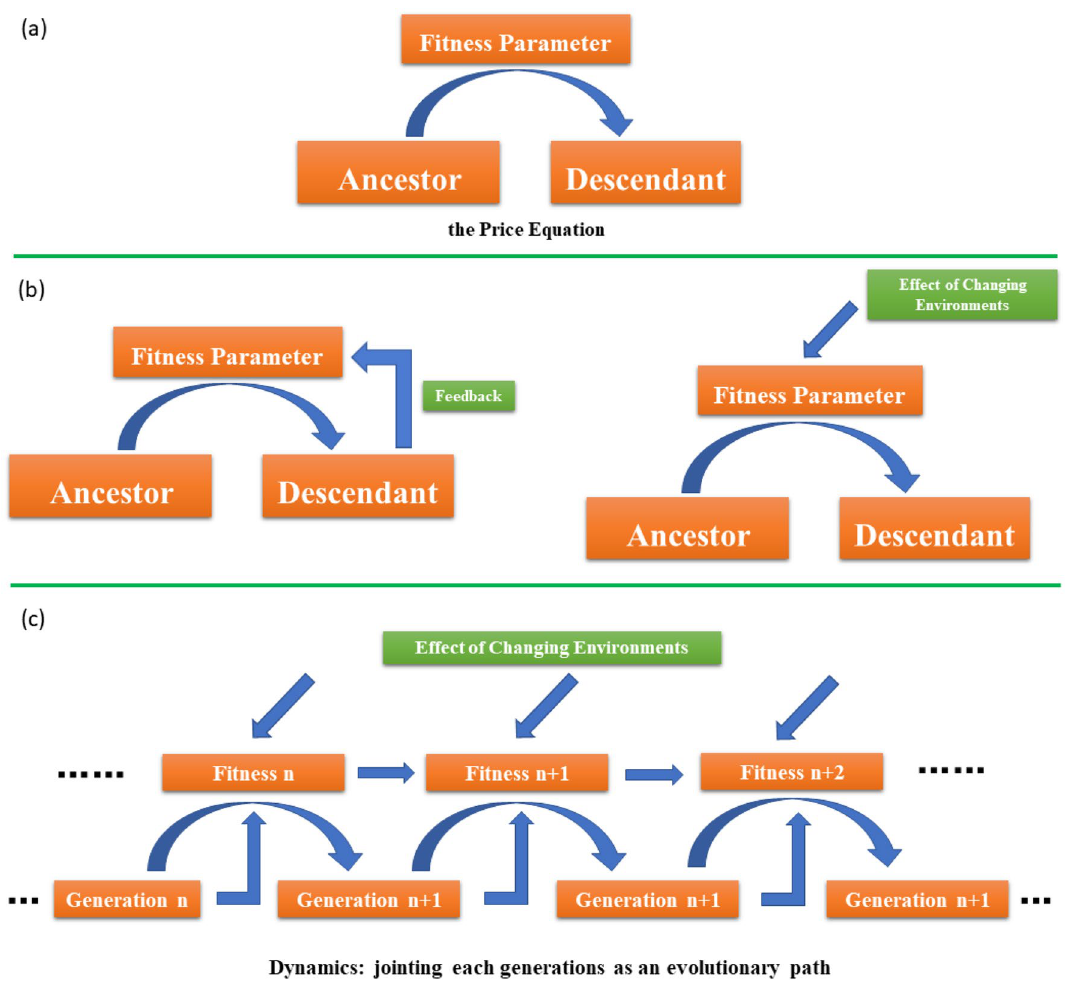
Figure 1. The Price equation and the evolutionary trajectory. ( a ) The Price equation describes evolutionary change between generations through the covariance of a character with its fitness. ( b ) The fitness of a generation might receive feedback originated from the change in quantity and character of the last generation or other more generations. The population distribution might also be affected by their living environments. ( c ) The whole evolutionary trajectory should be successive by jointing each generation step by